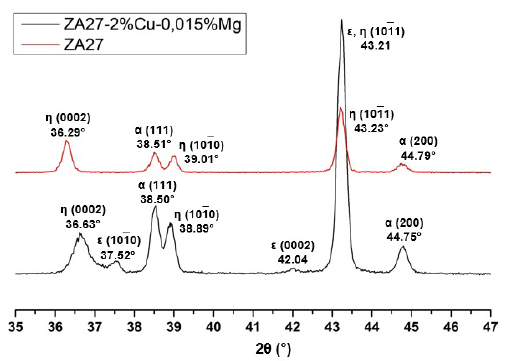
Figure 1. XRD pattern of as-cast ZA27 and ZA27-2%Cu-0.015%Mg